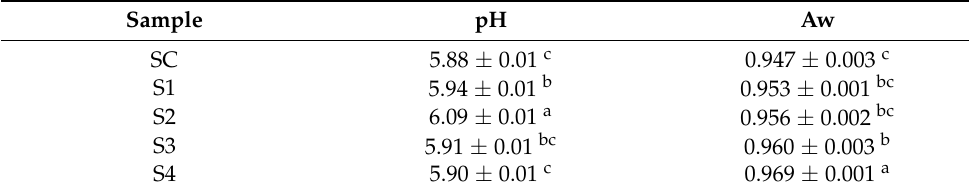
Table 3. Effect of partial and total replacement of pork back fat by the gelled emulsion, from hemp oil and buckwheat flour, on pH and water capacity of frankfurters.